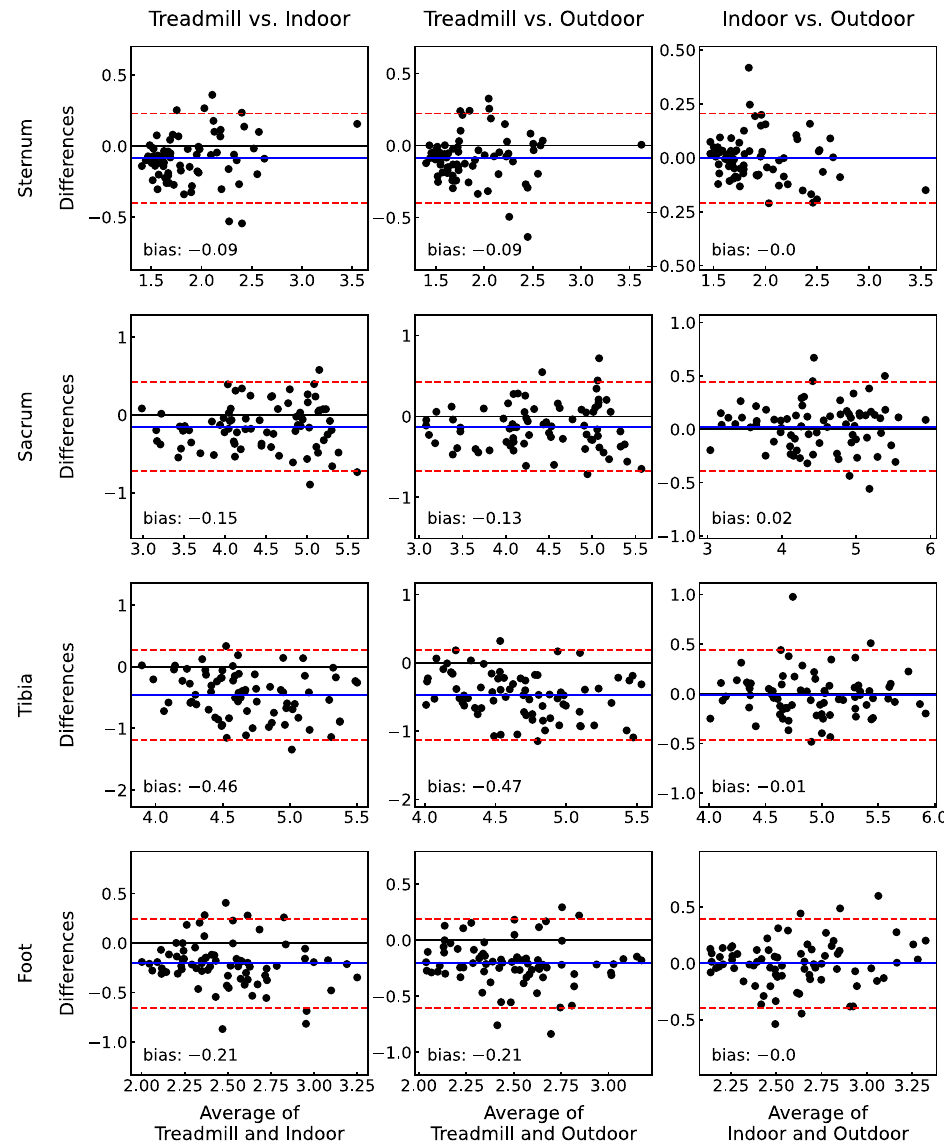
Figure 2. Bland–Altman plots for the agreement between the different conditions for all sensor locations. Solid green and dashed red lines represent bias and upper and lower limits of agreement, respectively. The condition mentioned first reflects the reference for the calculation.